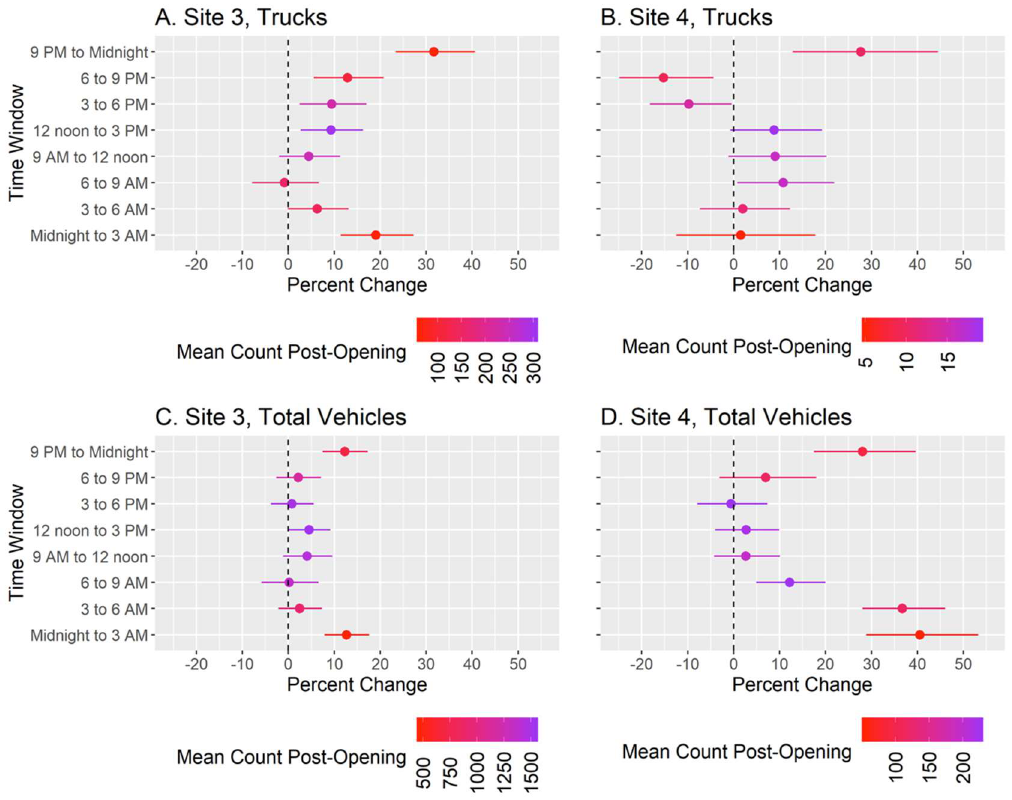
Figure 3. Percent change (points) and 95% confidence intervals (lines) in the truck flow at Site 3 (Panel A), truck flow at Site 4 (Panel B), total vehicle flow at Site 3 (Panel C), and total vehicle flow at Site 4 (Panel D) after the opening of an online grocery delivery service warehouse in a South Bronx neighborhood, compared to before the warehouse opened. Separate statistical models were completed for each three-hour time window; models controlled for day of the week and long-term and seasonal trends. Colors indicate the mean number of trucks or vehicles counted for a specific time window after the warehouse opened. Total vehicles include both cars and trucks.